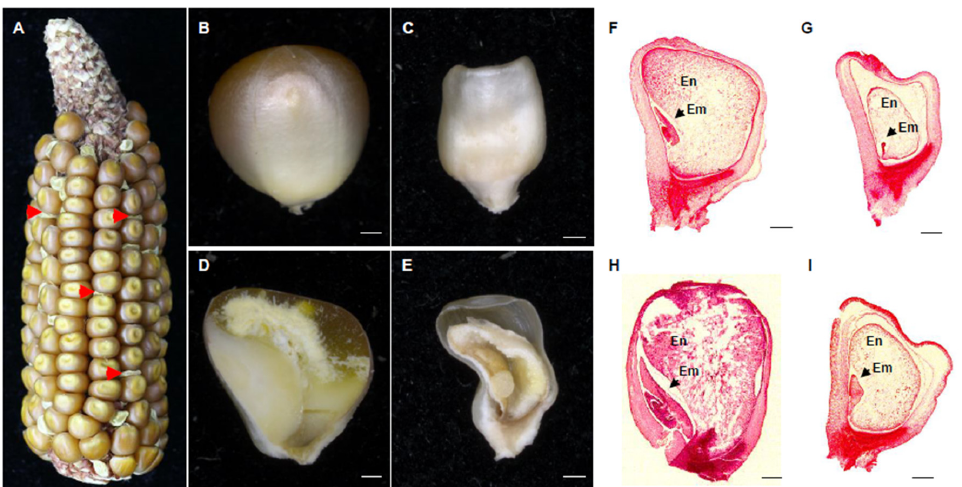
Figure 2. Mutant ppr18-1 kernels abort early in embryogenesis and endosperm development. ( A ) The mature ear segregates 3:1 for wild-type (WT) and ppr18-1 kernels at 35 days after pollination (DAP). The red arrows indicate the ppr18-1 kernels. ( B , C ) Mature wild-type ( B ) and ppr18-1 kernels ( C ) from ( A ). ( D , E ) Dissection of mature wild-type ( D ) and ppr18-1 kernels ( E ). ( F – I ) Paraffin sections of wild-type ( F , H ) and ppr18-1 kernels ( G , I ) at 9 DAP and 14 DAP. Wild-type kernels at 9 DAP ( F ) and 14 DAP ( H ); ppr18-1 kernels at 9 DAP ( G ) and 14 DAP ( I ). En, endosperm; Em, embryo. Scale bar, 1 mm in ( B – I ).